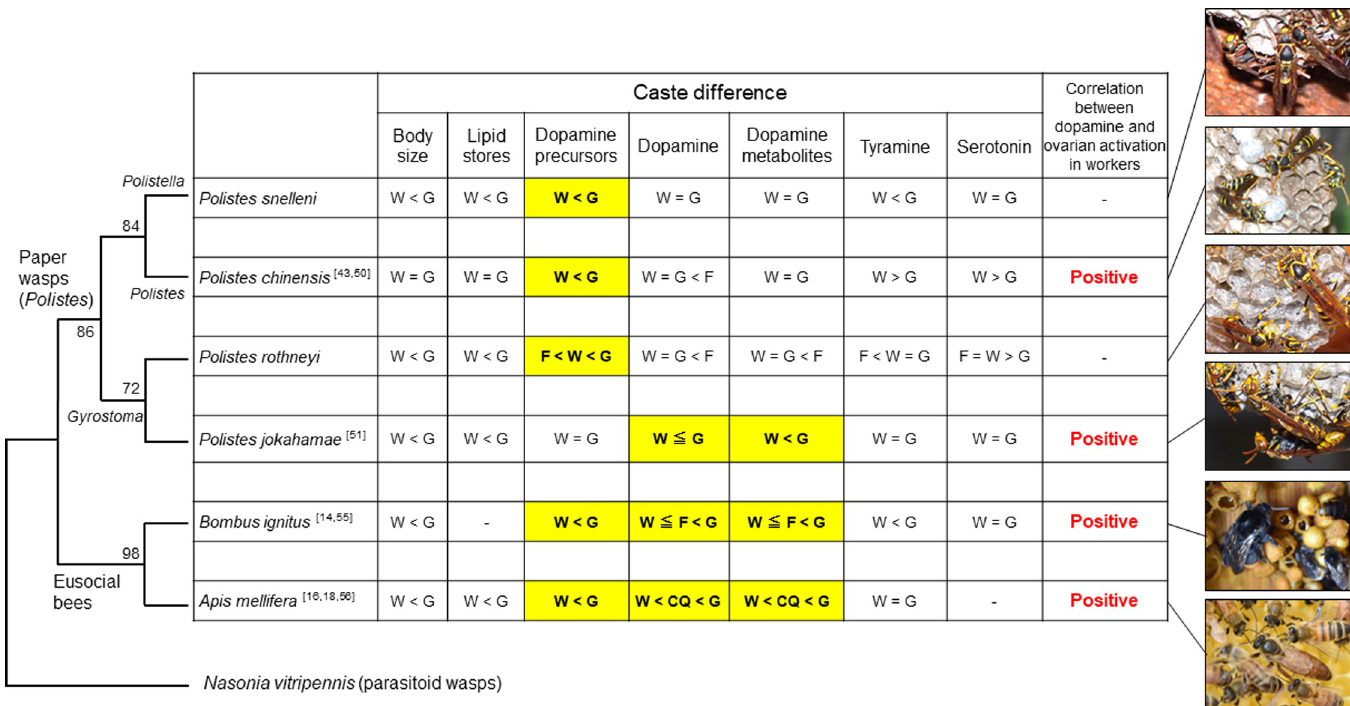
Fig 4. Comparison of caste differences in the body size, lipid stores and the levels of dopamine-related substances and other biogenic amines in the brains of four species of Polistes paper wasps and two species of eusocial bees. In the phylogenetic relationship, maximum likelihood trees were constructed using MEGA 11.0.10 software with 1,000-fold bootstrap re-sampling. The numbers at the nodes of the branches represent the levels of bootstrapping for each branch. Nasonia vitripennis 16S ribosomal RNA sequence was used as an outgroup. Dopamine precursors: tyrosine and L-DOPA, Dopamine metabolites: N -acetyldopamine and norepinephrine. CQ: colony queen, F: foundress, G: gyne, W: worker. Higher levels of dopamine-related substances in gynes than workers are highlighted as yellow. Reference papers are indicated as reference numbers beside the species name. Photos of the paper wasps and the eusocial bees were taken by M. Nishimura and K. Sasaki, respectively.